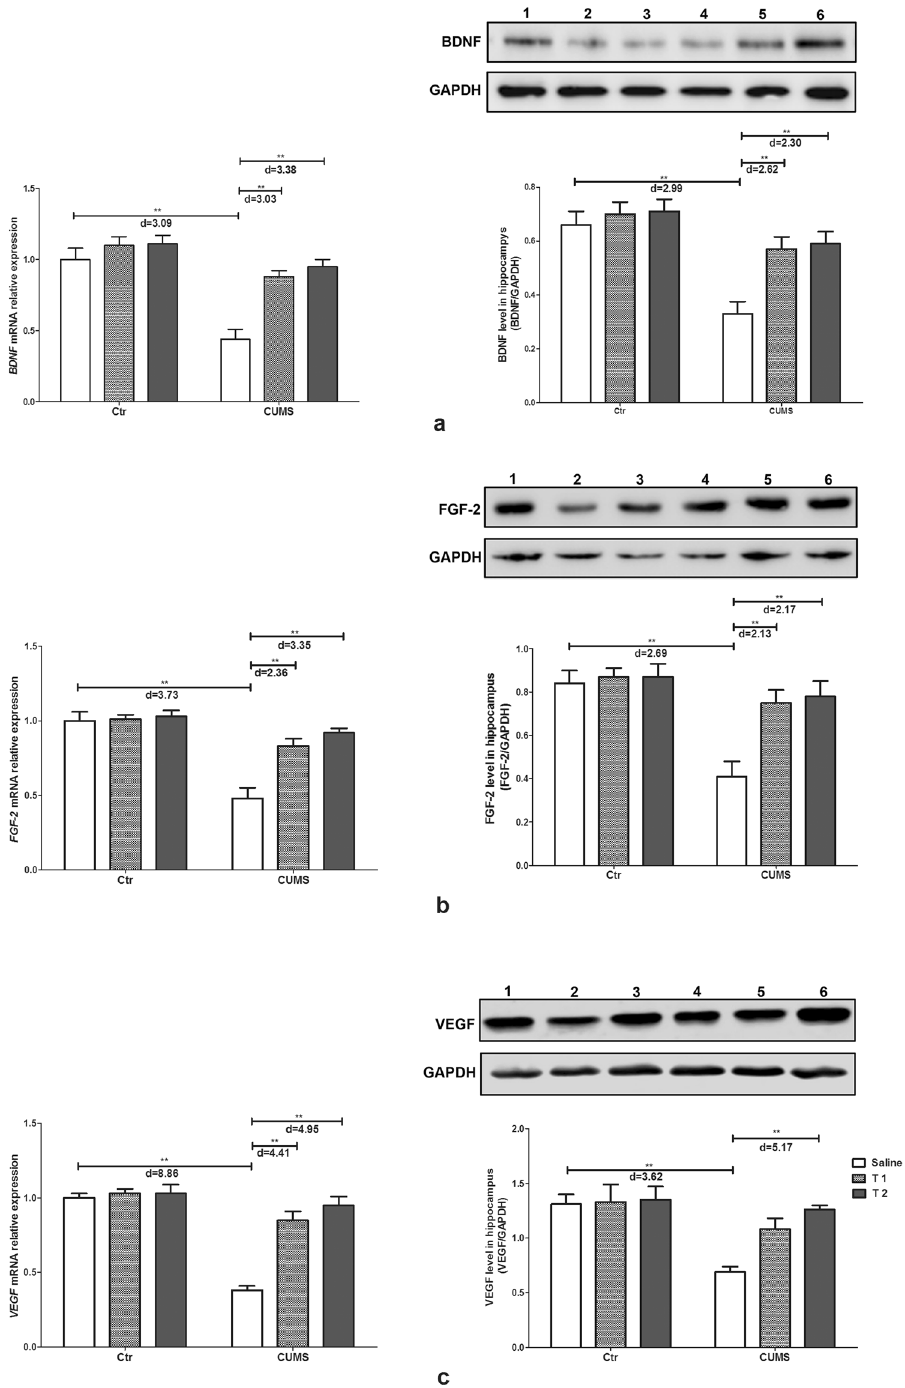
Figure 7. Effects of taurine on the expression of neurotrophic factors in the hippocampus. ( a ) BDNF mRNA and protein expression. ( b ) FGF-2 mRNA and protein expression. ( c ) VEGF mRNA and protein expression. Ctr, control group; CUMS, CUMS group; Saline, i.p. saline; T1, i.p. 200 mg/kg taurine; T2, i.p. 500 mg/kg taurine; In western-blot results, No.1, 2, 3, 4, 5, 6 represent the protein expressions of the control group, CUMS stress group, T1 + CUMS group, T2 + CUMS group, T1 group and T2 group respectively. All data are expressed as means ± SE and were analyzed by two-way ANOVA followed by Bonferroni’s multiple comparisons post hoc test (n = 6). * P < 0.003 vs. CUMS group; ** P < 0.00067 vs. CUMS group. d means Cohen’s d, d = 0.20 was considered as small effect size, d = 0.50 was considered as medium effect size, d = 0.80 was considered as large effect size. Full-length blots are presented in Supplementary